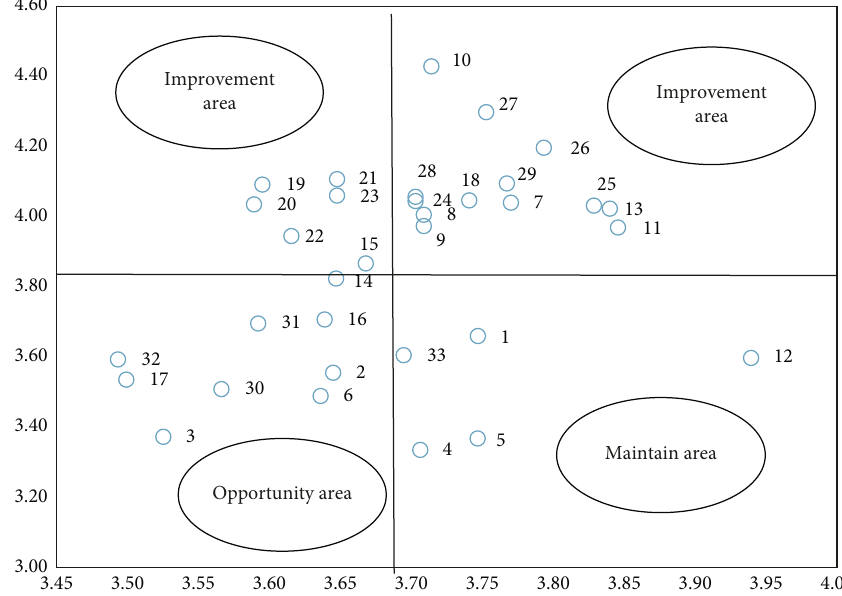
Figure 8: Analysis of public health service quality of rural tourism in